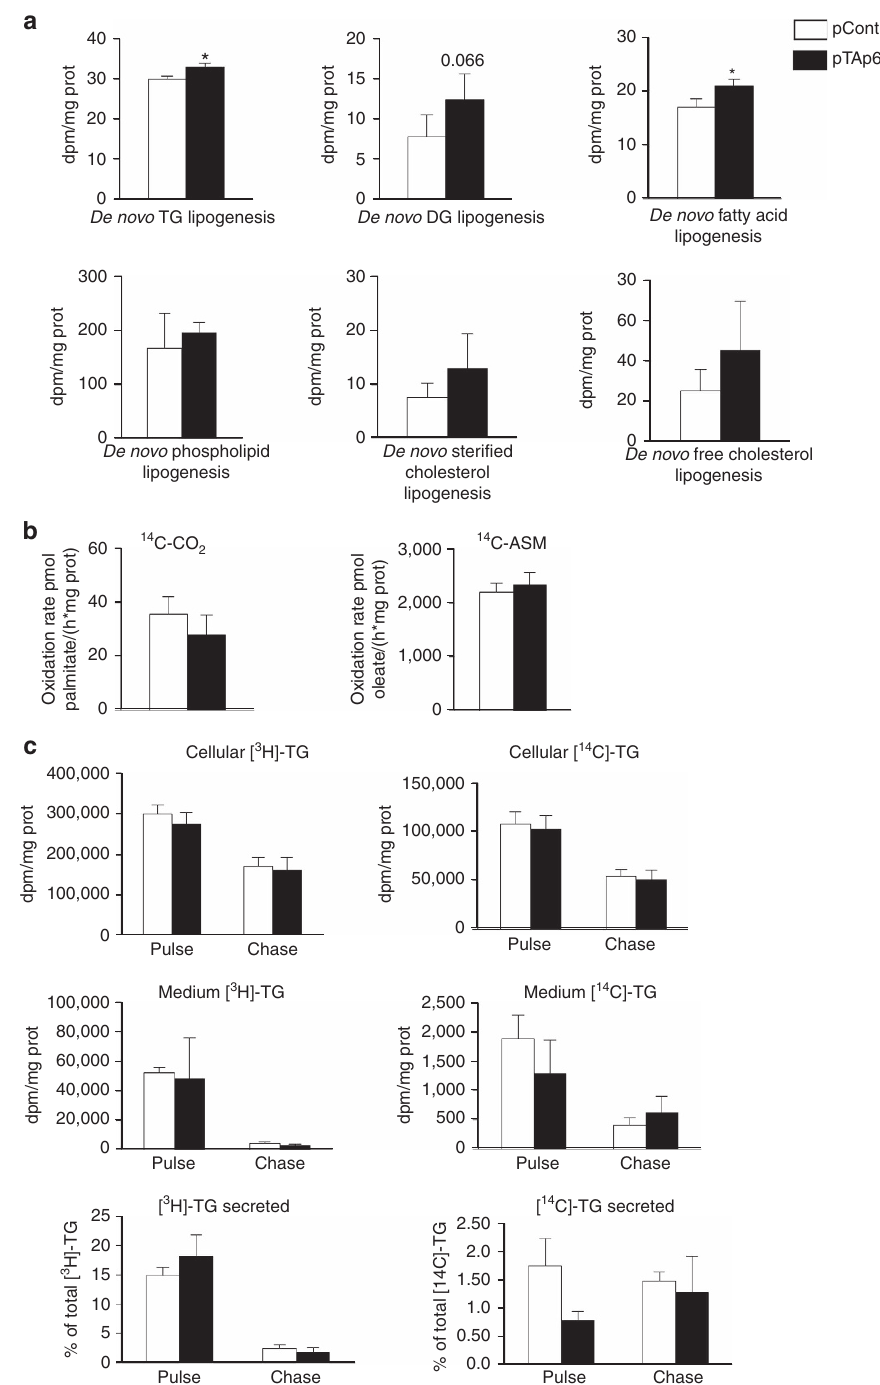
Figure 9 | TAp63 a stimulates lipogenesis in THLE2 cells. ( a ) De novo triglyceride (TG), diacylglicerol (DG), fatty acid, phospholipid, esterified cholesterol and free cholesterol lipogenesis ( n ¼ 4 per group); ( b ) palmitate oxidation ( n ¼ 4 per group); and ( c ) lipid turnover in THLE2 cells transfected with empty plasmid control and plasmid encoding TAp63 a ( n ¼ 4 per group). Data are presented as mean ± standard error mean (s.e.m.). Statistical differences are denoted by * P o 0.05, ** P o 0.01 and *** P o 0.001, was tested using Student t